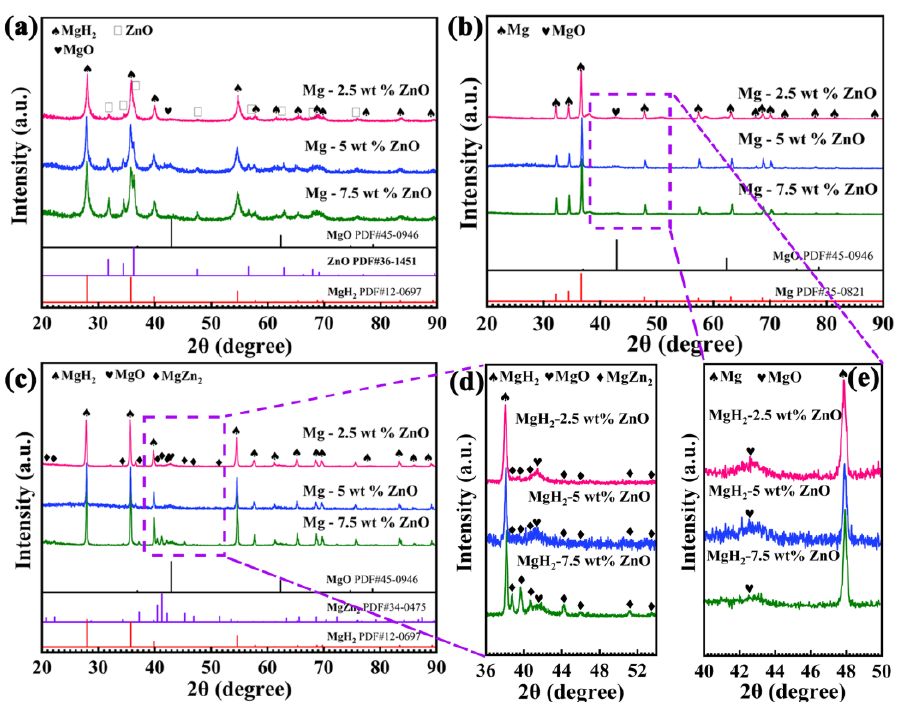
Figure 3. XRD patterns of MgH 2 -xZnO with different sates: ball milling ( a ); after hydrogen release ( b ); and after re-hydrogen ( c ); amplification diagram of re-hydrogenation ( d ); and amplification diagram of dehydrogenation ( e ).